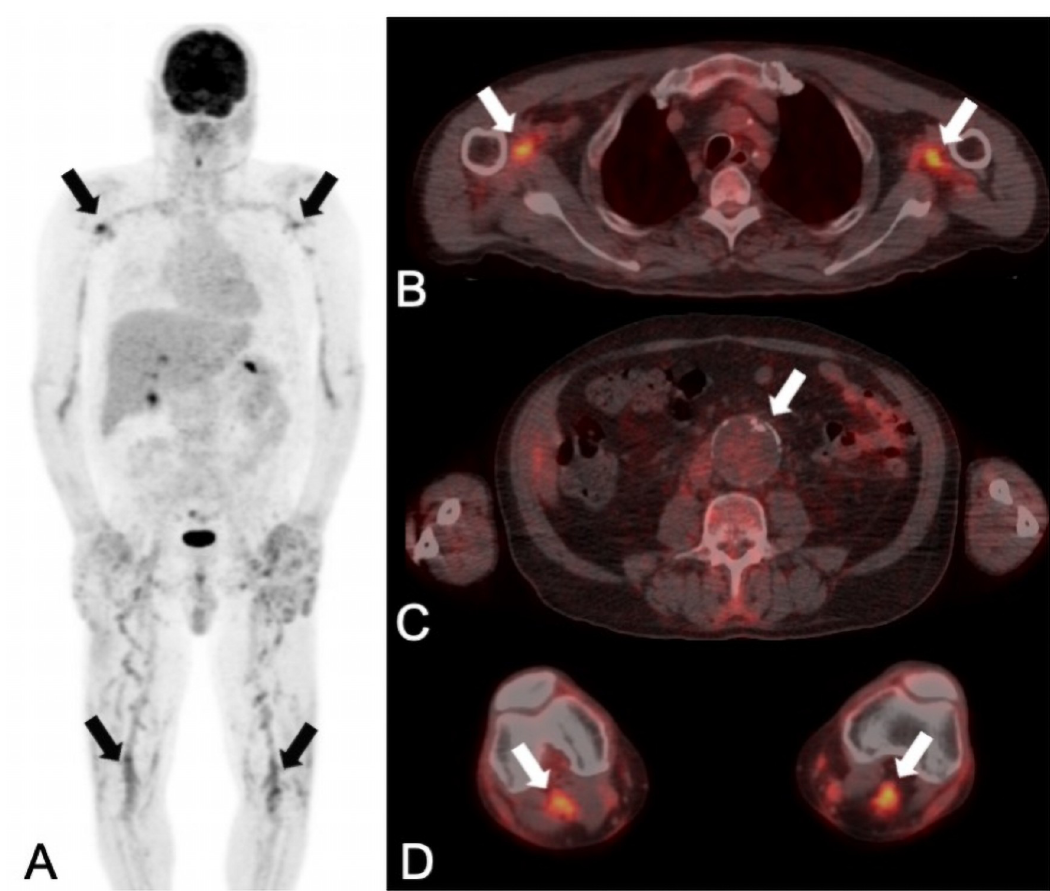
Fig 4. PET/CT with confirmed impact on management of an incidental finding. A 61-year old man was presented with recurrent episodes of fever and an elevated C-reactive protein level (154 mg/L). A PET/CT with the question for mycotic aortic aneurysm (MAA) or recurrence of lymphoma was acquired (A: maximum intensity reconstruction, B, C and D: fused axial PET/CT images). Lymphoma recurrence and MAA were correctly ruled out by both readers (no increased uptake in the abdominal aneurysm (white arrow in C)), as confirmed by long-term clinical follow-up. As an incidental finding with impact on patient management, PET/CT detected arteritis of the peripheral arteries (as demonstrated in the axillary (upper black arrows in A and white arrows in B) and popliteal arteries (lower black arrows in A and white arrows in D)). At the last clinical visit (826 days after PET/CT) the patient had continuous therapy with glucocorticoids. The patient was doing fine with no clinical signs of recurrent lymphoma, infection or